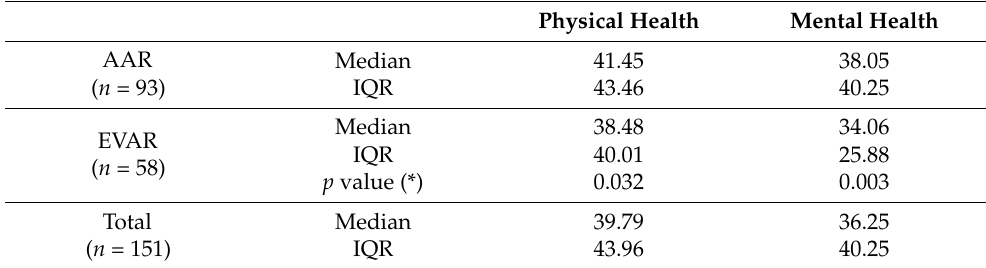
Table 5. Summary measures in patients operated on for AAA by AAR and